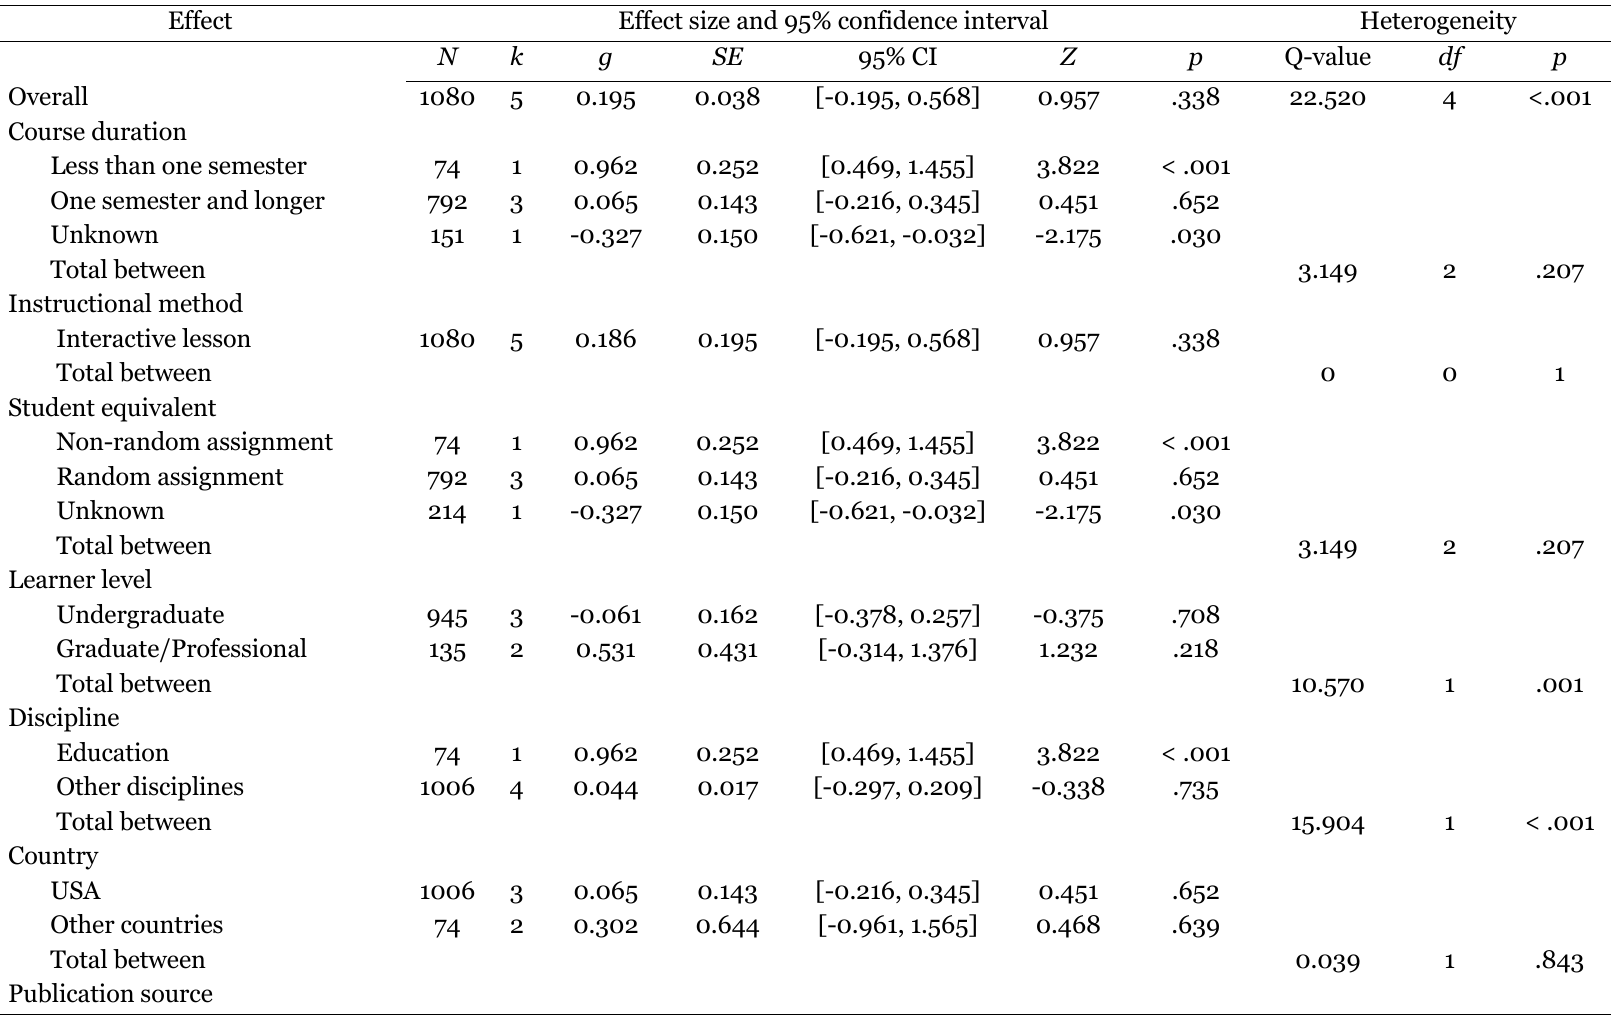
Table D Moderator Analyses (Synchronous vs. Face-to-Face Affective